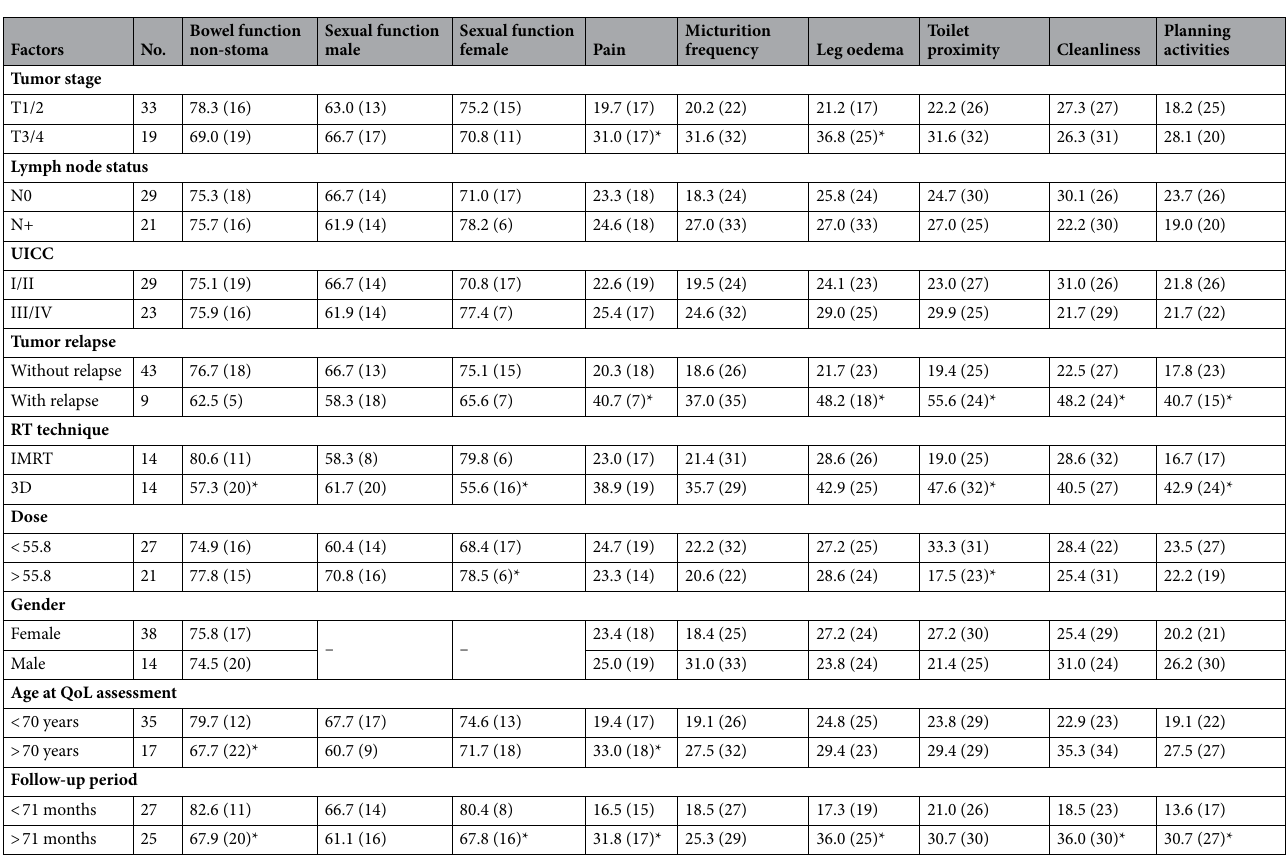
Table 3. QLQ-ANL27 questionnaire: patient-, tumor- and therapy-related factors. *Statistically significant. Standard deviation inside the